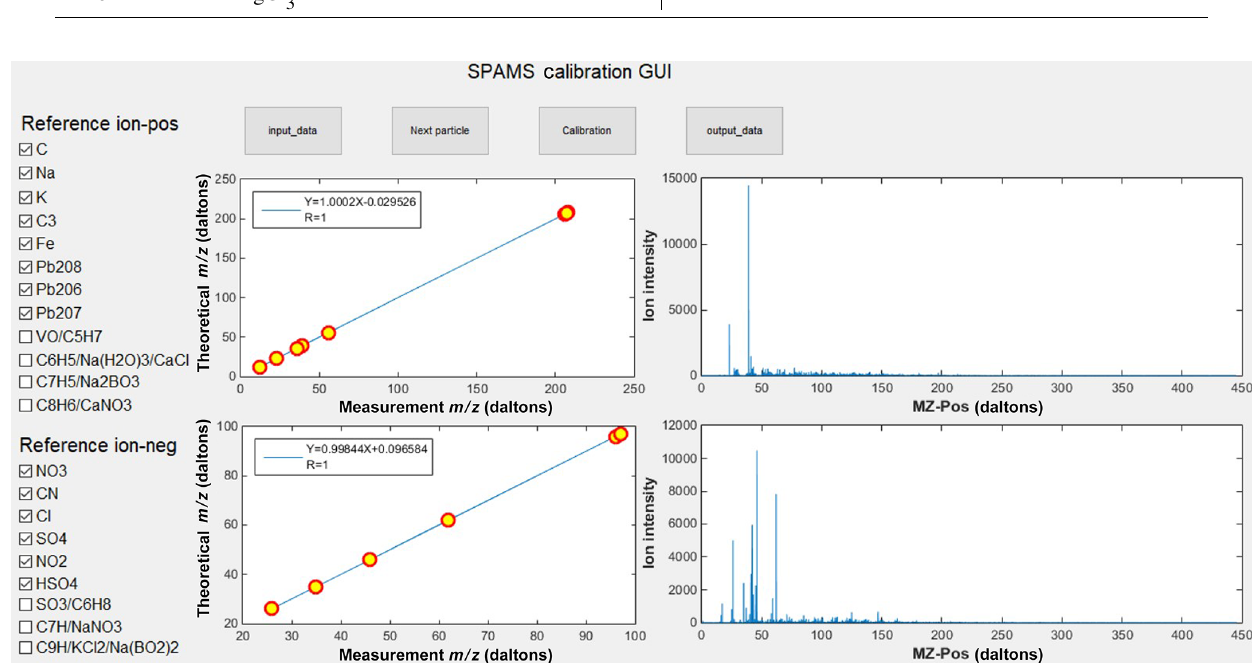
∼ 29 . 0 % of total ambient particles had a sufficient num- respectively, which were larger than the m/z deviations of ber of reference ions in their positive spectra. To solve this these reference ions in coarsely calibrated spectra. Therefore, , problem, extra reference ions, including 67 VO + , 67 C 5 H + the coarsely calibrated spectra can be used to determine these 7 + 89 C , 89 Na 2 BO + , 102 C 8 H + and 102 CaNO + , were added specific reference ions. With these additional potential refer- 7 H 5 2 6 3 into the original positive reference ion pool. Obviously, these ence ions, a total of 2490 ambient particles were calibrated, ions share the same integer m/z value with other ions. We much more than in the previous analysis (1409 ambient par- needed to identify them using additional information other ticles). The deviations from the theoretical m/z for applying than their integer m/z values. this expanded ion pool are summarized in Table S3. The av- The specific reference ions were determined by their erage m/z deviation of the reference ions is ∼ 0 . coarsely calibrated m/z . Table S2 in the Supplement shows that the m/z deviation ranges of the reference positive ambi- ent ions in coarsely calibrated spectra before automatic linear calibration were around 0.011–0.048, while the m/z differ- ences between 67 VO + and 67 C 5 H + , 89 C 7 H + and 89 Na 2 BO + , 7 5 2 and 102 C 8 H + and 102 CaNO + were 0.1213, 0.0622 and 0.083, 6 3